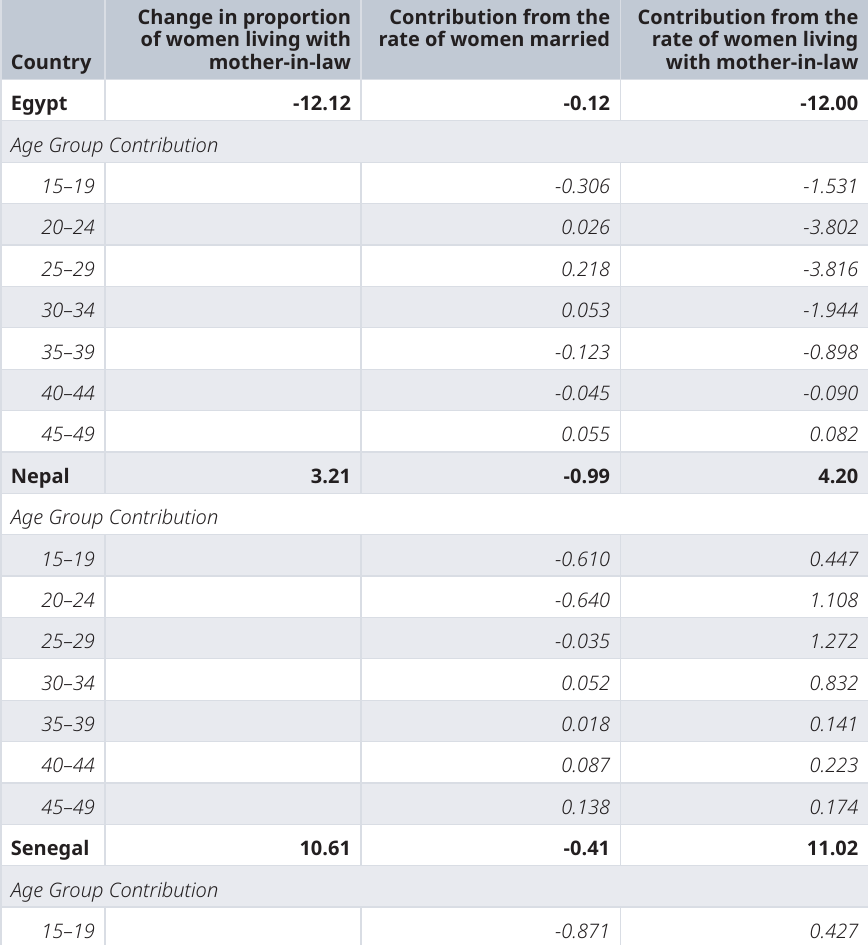
Table 3. Decomposition of the rates of women married and living with their mother-in- law.